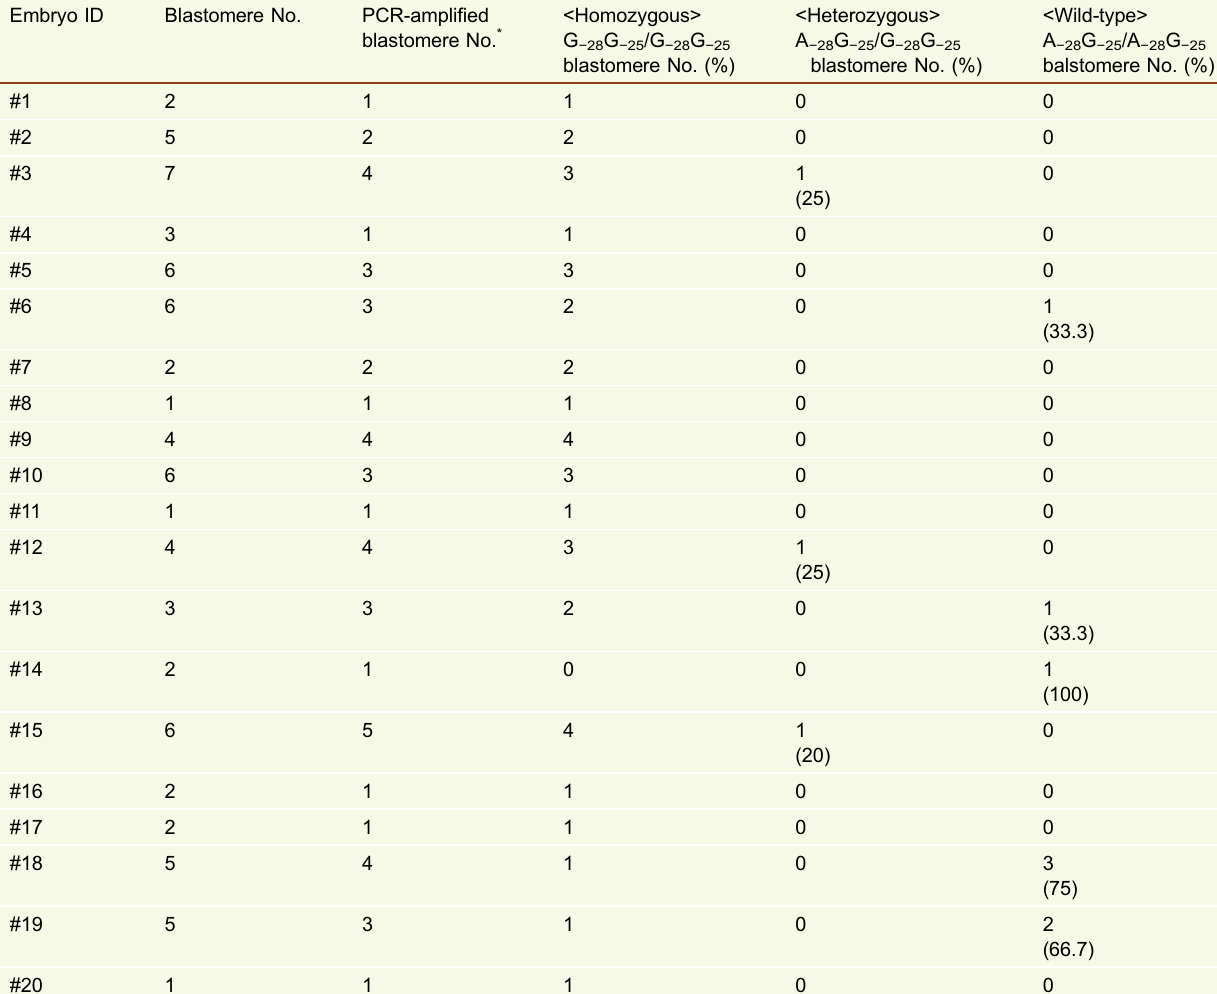
Table 1. Summary of base editing-mediated point mutation repairing by YEE-BE3 in human embryos Embryo ID Blastomere